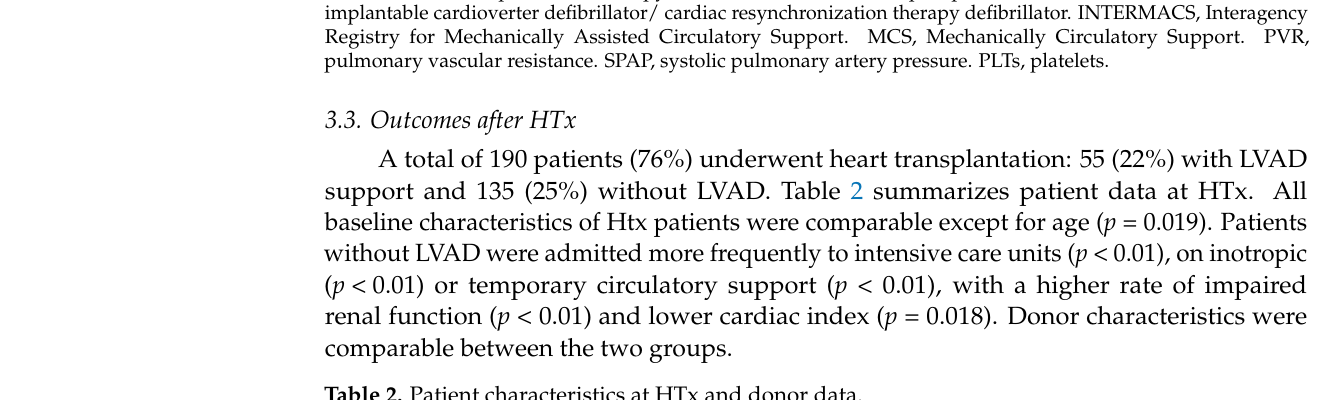
Table 2. Patient characteristics at HTx and donor